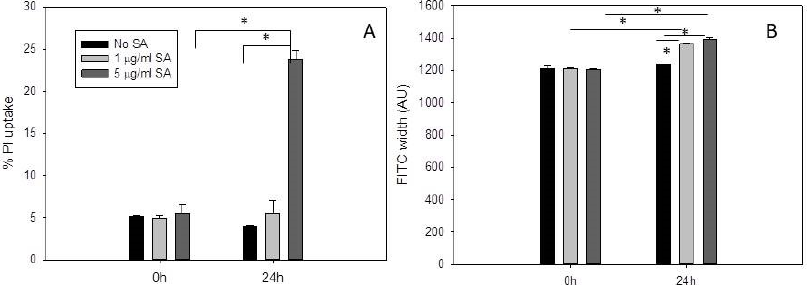
Figure 1. Incubation with Saponinum album at a concentration of 5 µ g / mL Saponinum album (SA) for 24 h increases propidium iodide (PI) uptake in Daudi cells previously incubated with OKT10-SAP-AF for 24 h. ( A ) Percentage propidium uptake into Daudi lymphoma cells exposed to OKT10-SAP-AF for 24 h prior to incubation in the absence (black) or presence of 1 µ g / mL SA (light grey) or 5 µ g / mL SA (dark grey) for 0 and 24 h. ( B ) Fluorescein isothiocyanate (FITC) width values in arbitrary units obtained for OKT10-SAP-AF in Daudi cells in the absence (black) or presence of 1 µ g / mL SA (light grey) or 5 µ g / mL SA (dark grey) for 0 and 24 h. Data presented are the average of three experiments and the error bars represent one standard deviation either side of the mean. * p < 0.005 determined using the Mann–Whitney U